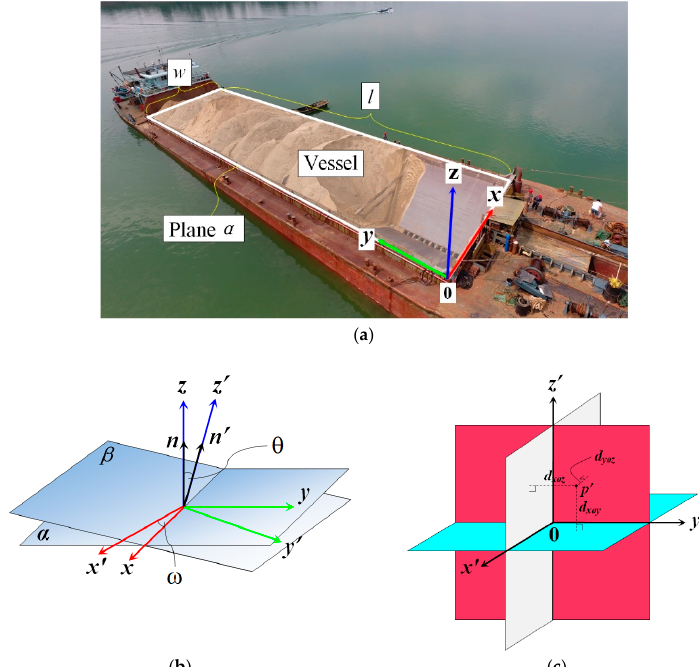
Figure 11. Custom-built framework: ( a ) a custom-built framework that is established using a horizontal plane α with known length l and width w ; ( b ) the spatial geometric rotation between the custom-built coordinate system O-XYZ and an auxiliary coordinate system O-X’Y’Z’; ( c ) the transformation of a photogrammetric point p’ from the arbitrary coordinate system to the auxiliary coordinate system.